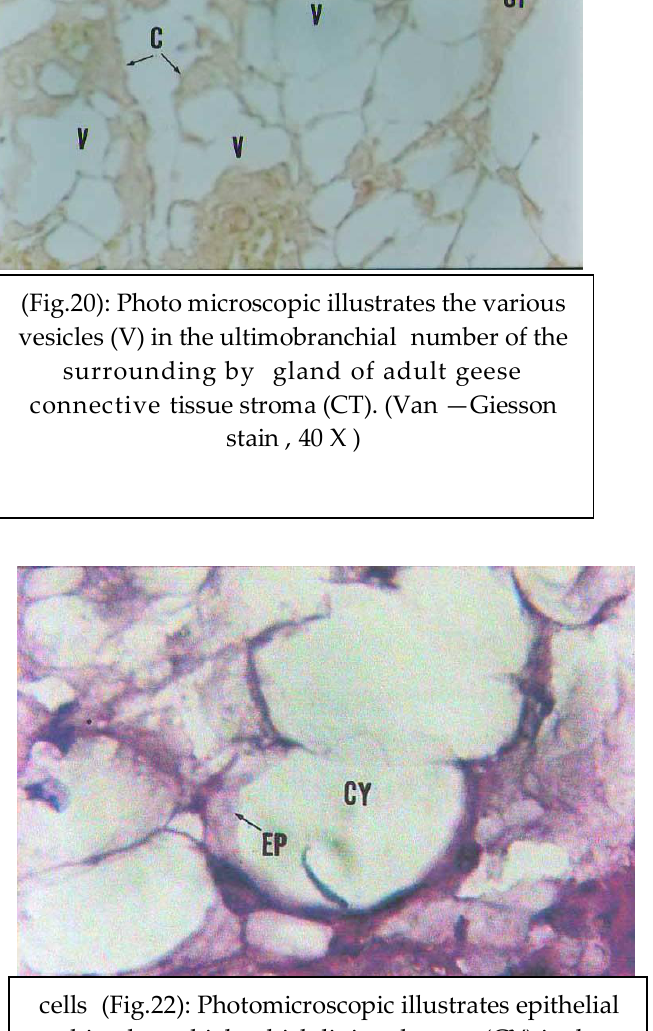
which lining the cyst (CY) in the ultimobranchial